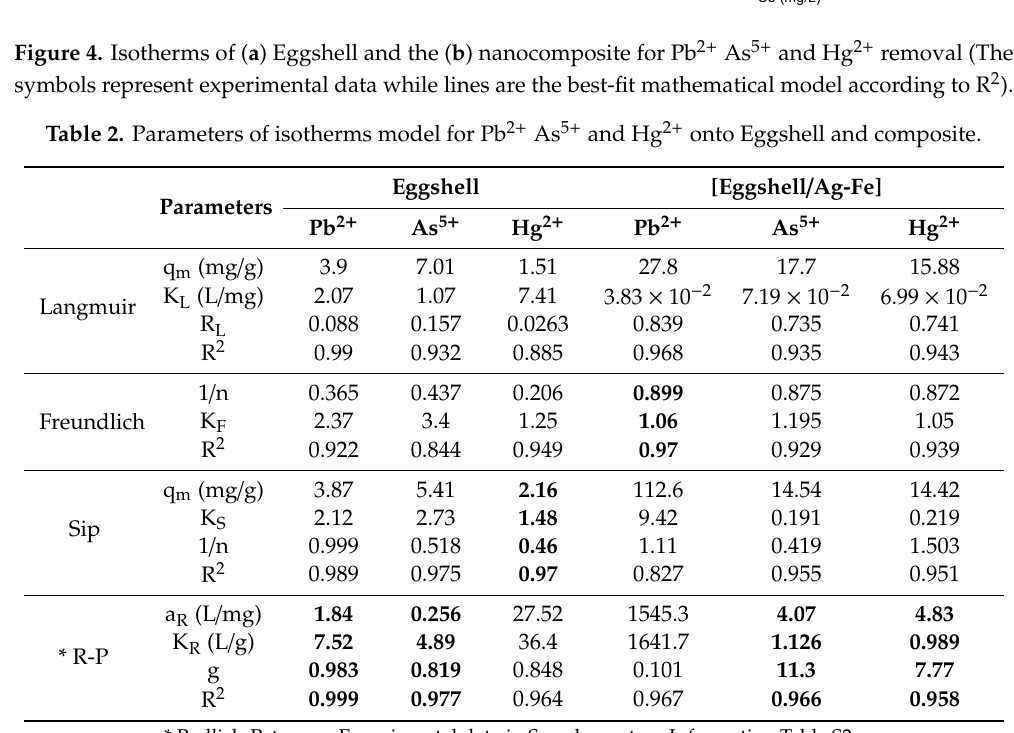
* Redlich-Peterson. Experimental data in Supplementary Information Table